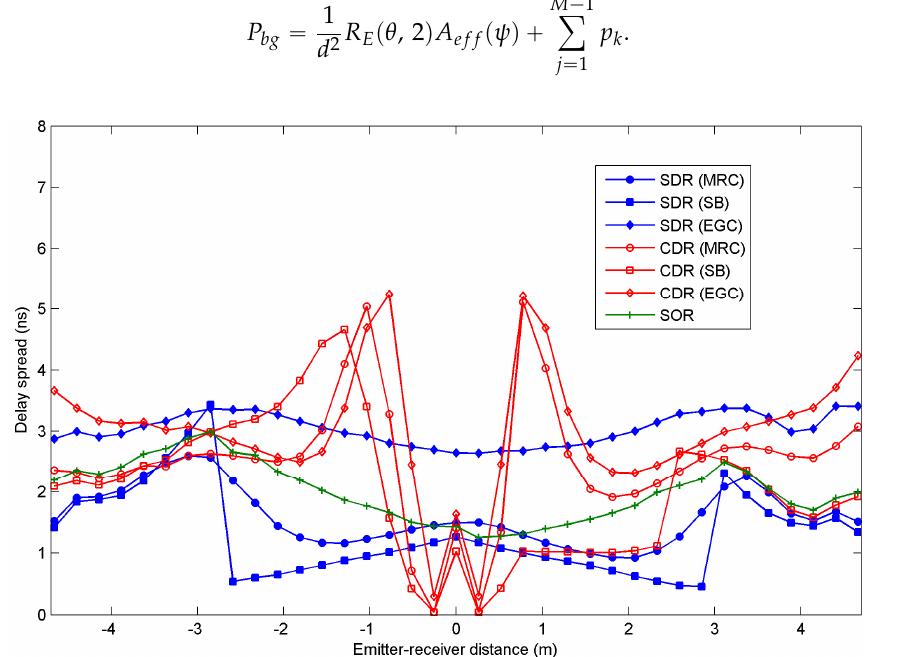
Figure 5. Delay spread for the sectored angle-diversity receiver (SDR), the conventional angle-diversity receiver (CDR) and the self-orienting receiver (SOR) as a function of the emitter-receiver distance along the diagonal from northwest (negative values) to southeast (positive values).